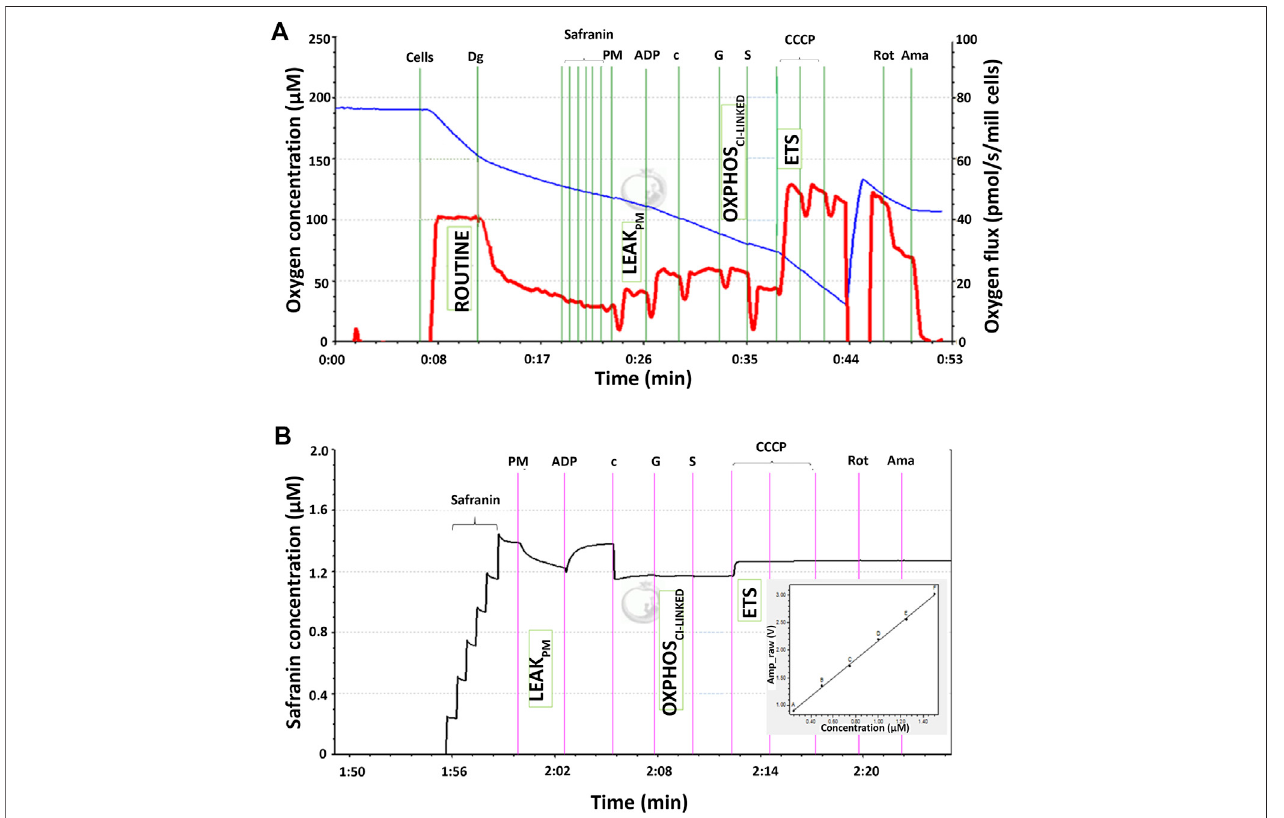
FIGURE 1 | Qualitative data for simultaneous high-resolution respirometry analysis of (A) the respiratory capacity at four selected mitochondrial bioenergetics states: ROUTINE, LEAK PM , OXPHOS CI-LINKED , and ETS expressed as the oxygen fl ux (pmol/s/mill cells) represented by the red line and (B) membrane potential at three selected mitochondrial bioenergetic states: LEAK PM , OXPHOS CI-LINKED , and ETS. The black line corresponds to the safranin concentration in the chamber medium and is directly proportional to the safranin signal expressed as amperes (amp). The membrane potential was inversely proportional to the safranin signal and thus calculated as 1/amp.